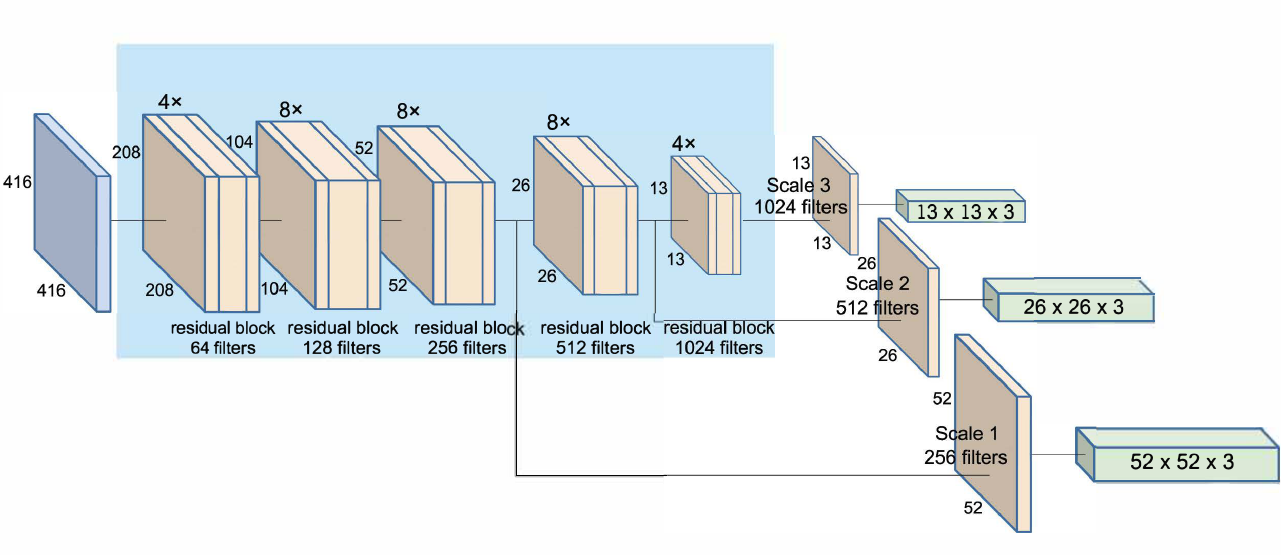
Figure 3. YOLO-Face (deeper darknet) architecture. The network uses different map scales to extract features, and it has a similar structure to FPN